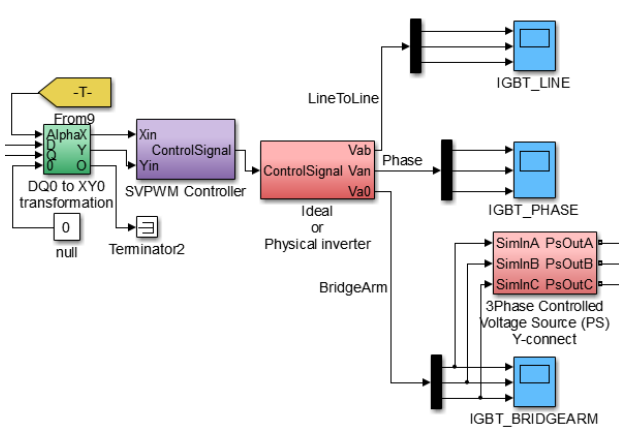
Fig. 3. Simulink model, part 2, (SVPWM inverter and scopes). The ideal inverter mode voids dead times and switching losses while physical inverter includes them. The simulation runs much faster using the ideal inverter.